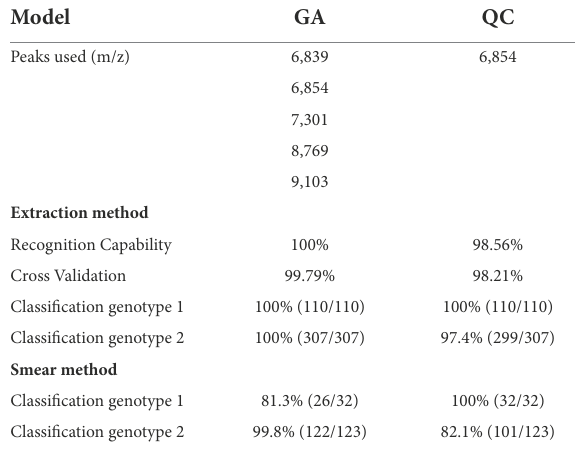
TABLE 2 Biomarker model characteristics and accuracy results for both the GA and QC biomarker